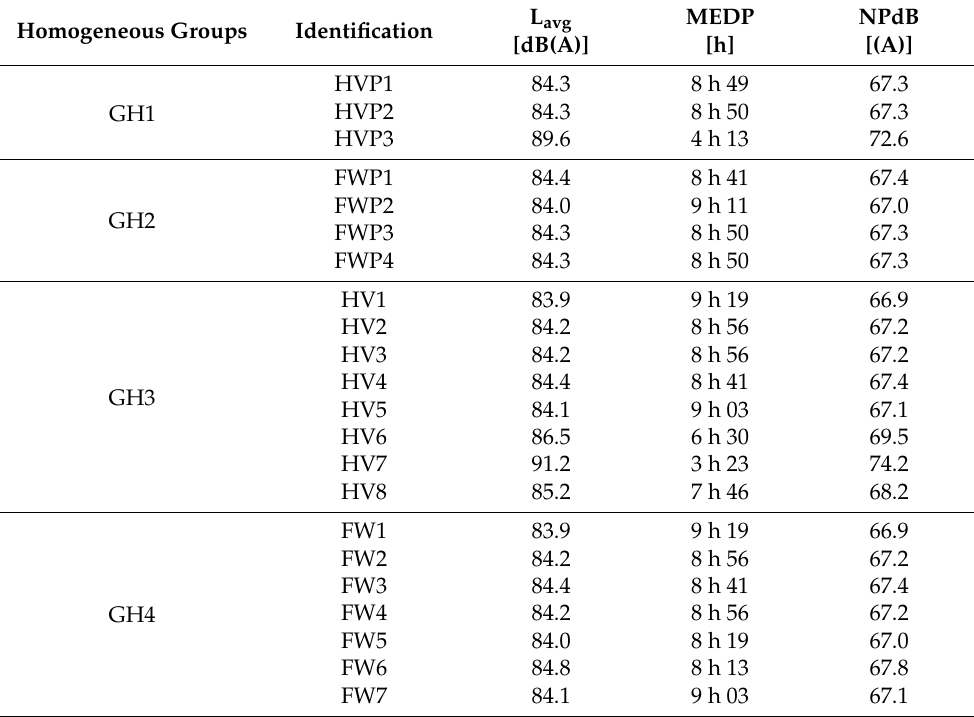
Table 3. Average levels of daily exposure to occupational noise, maximum allowable daily exposure and protection